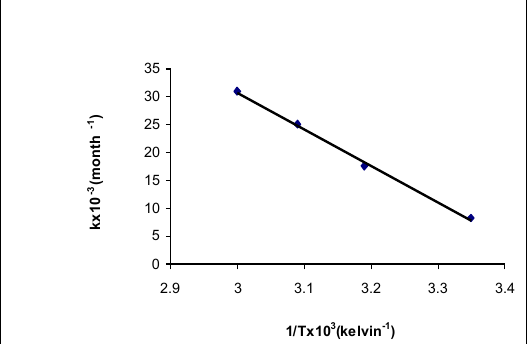
F igure (5): Arrhenious plot for estimation of the expiration date of formula II at 25 0